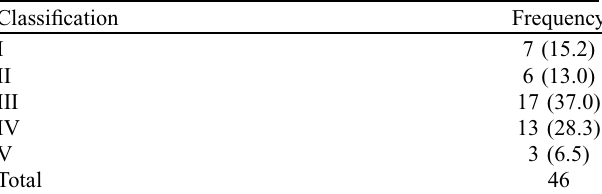
Table 2. Classification of the abductor muscles